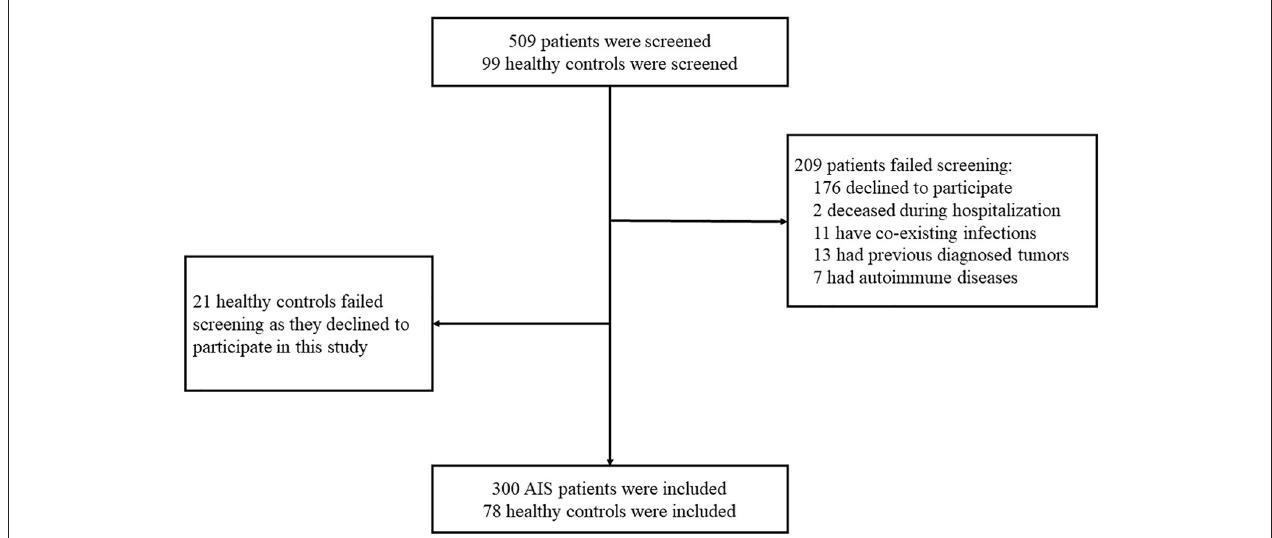
FIGURE 1 | Subjects screening